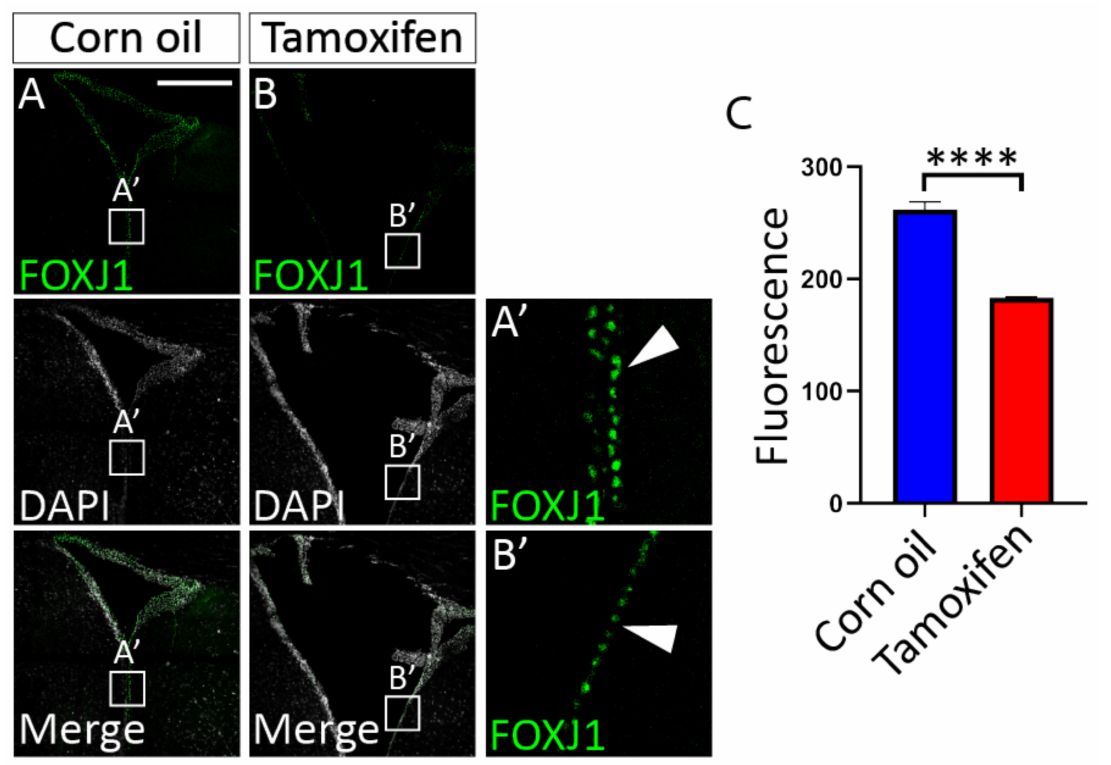
Figure 7. Loss of NFIX from adult ependymal cells resulted in reduced FOXJ1 expression. ( A , B ) Depth matched images of the lateral ventricles from adult corn oil ( A ) and tamoxifen ( B ) treated Nfix iFOXJ1 − GFP mice stained with antibodies against ependymal marker FOXJ1 (green) and nu- clear marker DAPI (grey) displayed separately and merged. ( A’ , B’ ) Regions depicted in boxes ( A’ , B’ ) are enlarged in panels ( A’ , B’ ). ( A’ , B’ ) Images depict FOXJ1 positive cells with a white arrowhead indi- cating a single FOXJ1 + cell. Tamoxifen treated Nfix iFOXJ1 − GFP mice have visibly reduced expression of FOXJ1. ( C ) Fluorescent intensity measurements of FOXJ1 in adult Nfix iFOXJ1 − GFP ependymal cells treated with tamoxifen compared to controls. Tamoxifen treated Nfix iFOXJ1 − GFP mice demonstrate significantly reduced expression of NFIX compared to controls. **** p < 0.0001, two-tailed t -test. Graphs depict mean ± s.e.m. from three samples per genotype, 50 nuclei per sample. Scale bar ( A ) represents 300 µ